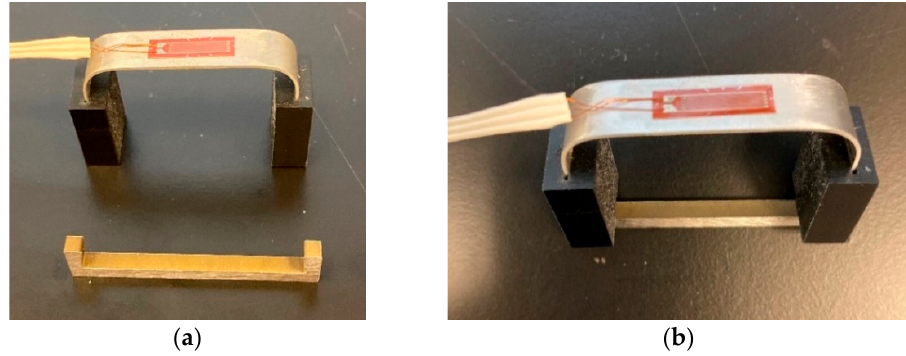
Figure 7. ( a ) Steel specimen before assembly ( b ) and after assembly.